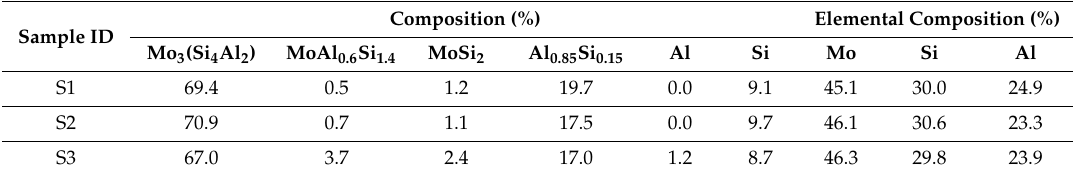
Figure 9. XRD patterns of samples S1 ( a ), S2 ( b ), and S3 ( c ). Table 6. Compositions of the samples estimated from XRD patterns via the Rietveld refinement